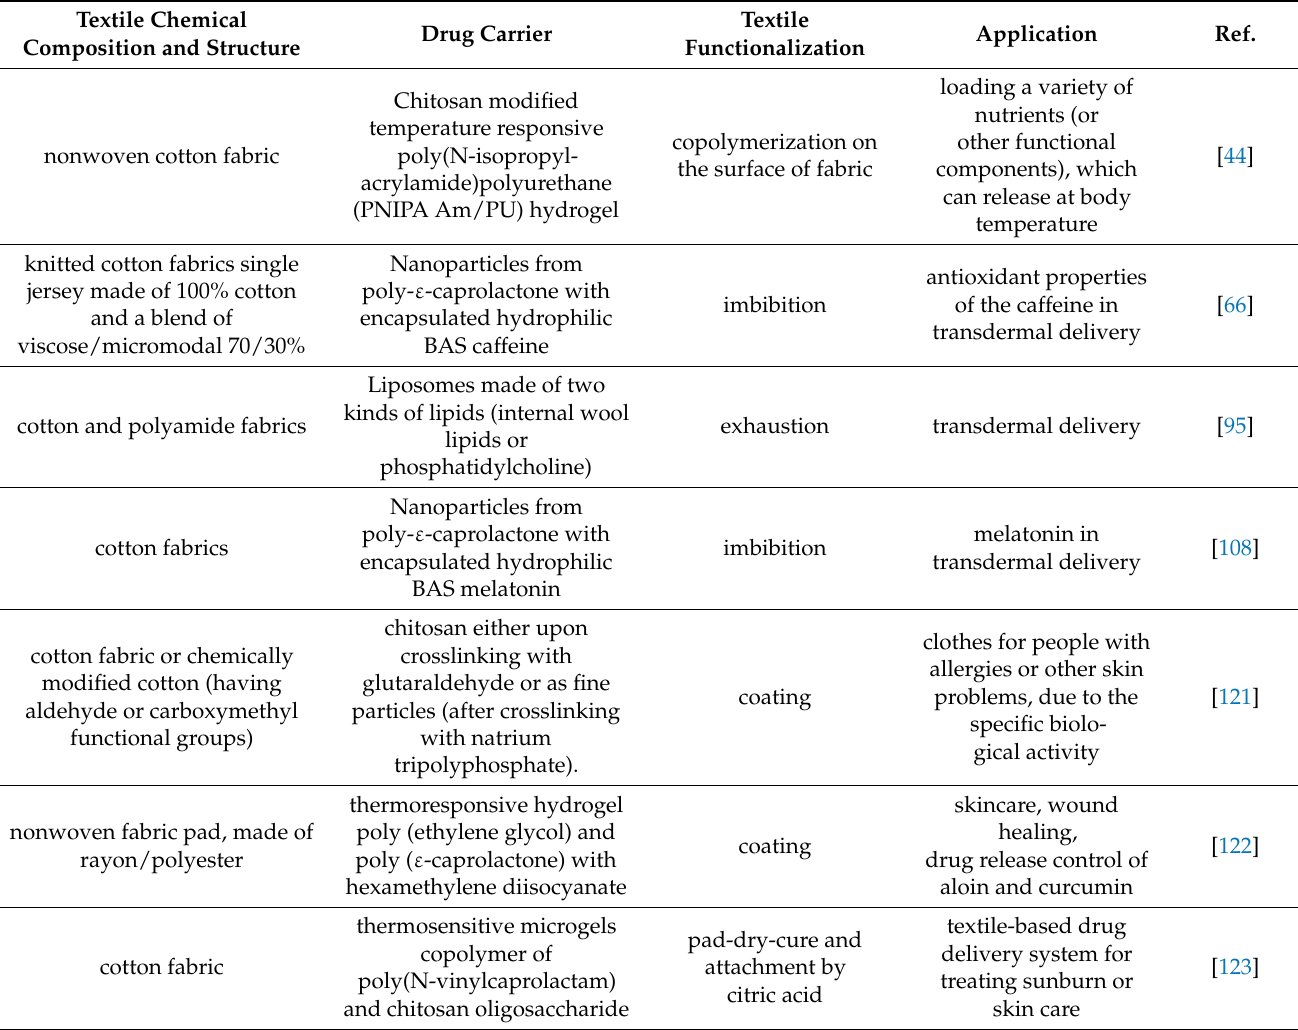
Table 1. Characteristics, functionalization, and application of biofunctional